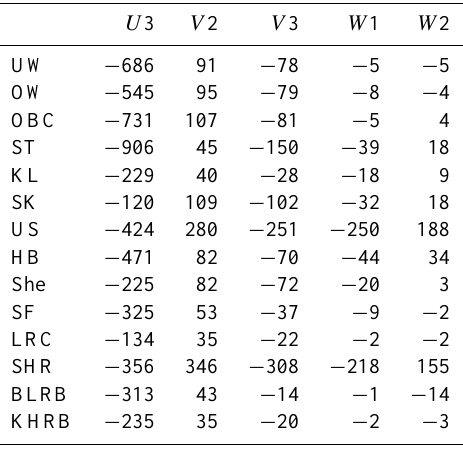
Table 7. Average net transport values across shelf break depth for all model simulations. Values are averaged during the advection- dominated phase (model days 4–10).